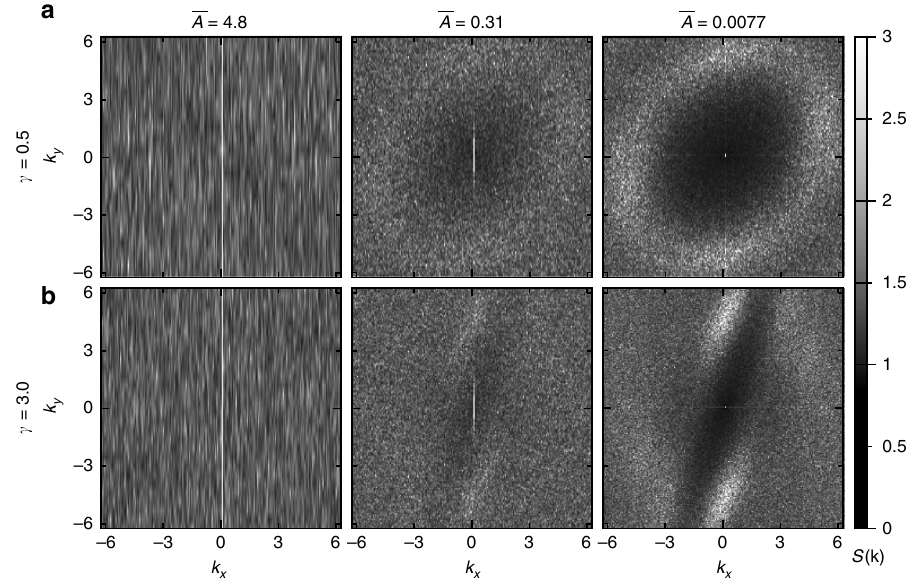
Fig. 3 Static structure factor. S ( k ) measured in 2D simulations with N = 4827, κ = 34.1, and ϵ = 0.5, at three values of A . Each panel is an average of 5 systems analyzed at a single snapshot in time in the steady state. Values are calculated using Eq. (2) at wavevectors k x and k y where an integer number of wavelengths fi ll the region populated by the particles. We avoid the diffuse boundary layer at the top of the sample by staying in the bottom 99% of the particles. a Results for γ = 0.5. At low A the structure factor is vanishing near the origin, signaling hyperuniformity. (The pattern is not radially symmetric because of the anisotropic driving.) b Results for γ = 3. Despite larger anisotropy in the structure, hyperuniformity occurs at low